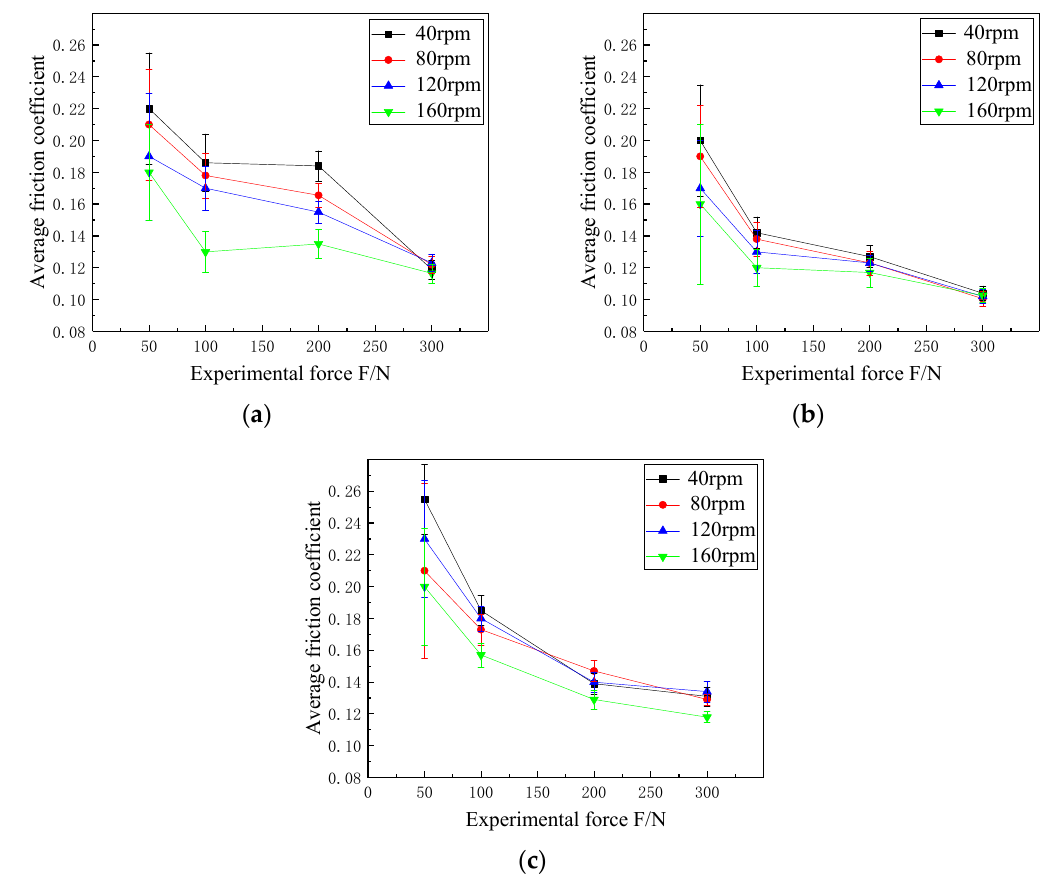
Figure 10. Friction coefficients of triangular groove textured surface with different area occupancy ratios: ( a ) area occupancy ratio of 7%; ( b ) area occupancy ratio of 10%; ( c ) area occupancy ratio of 13%.